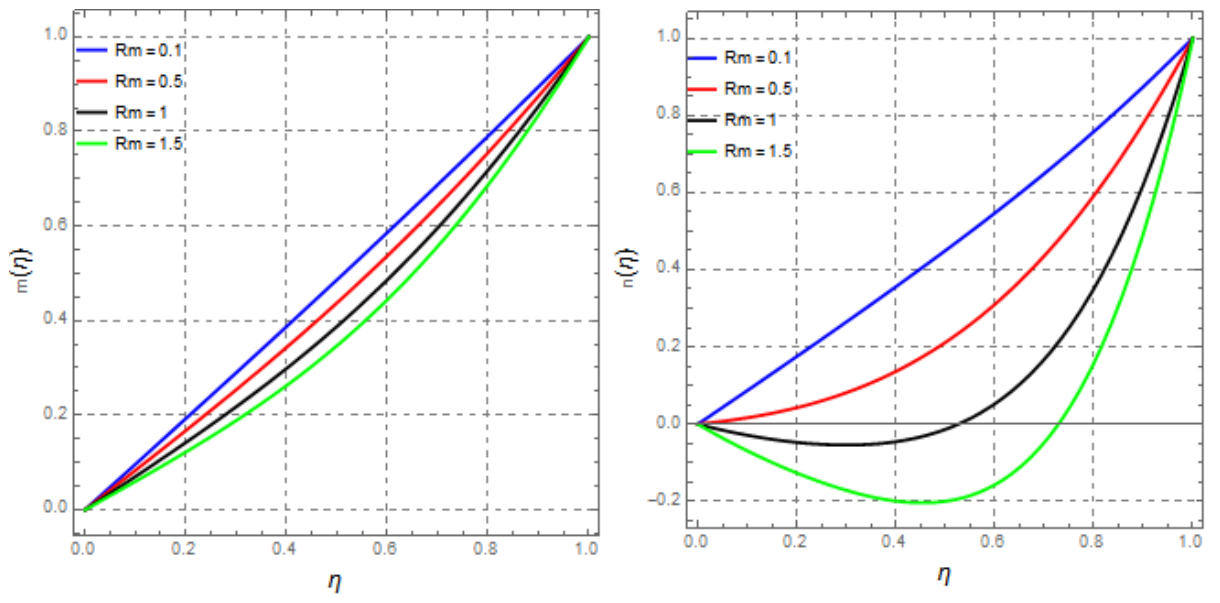
Figure 15. Impact of magnetic Reynolds number R m on magnetic field components m and n , keeping S z = − 1.5, M x = − 0.75, M y = 1, and S =